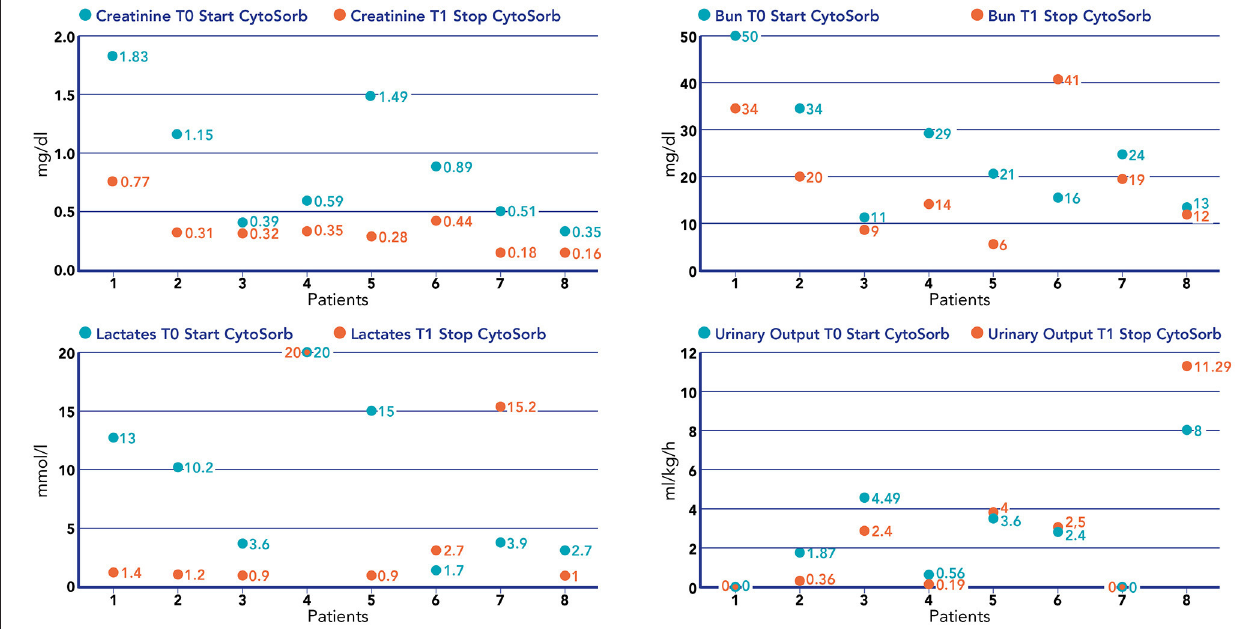
in Figure 3 . Continuous veno-venous hemofiltration was the preferred modality in one patient whereas seven patients were treated with CVVHDF. We have calculated the median values and quartiles (Q 1 ,Q 3 ) before (T0) and after (T1) hemoperfusion of creatinine (mg/dl) (T0 median 0.74 [Q 1 0.42, Q 3 1.40];